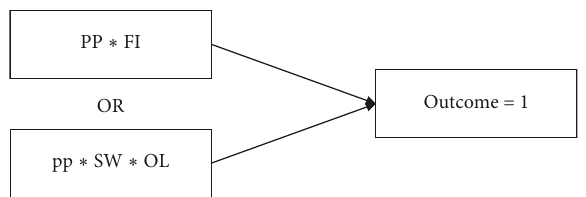
Figure 7: Credit default solution formula.